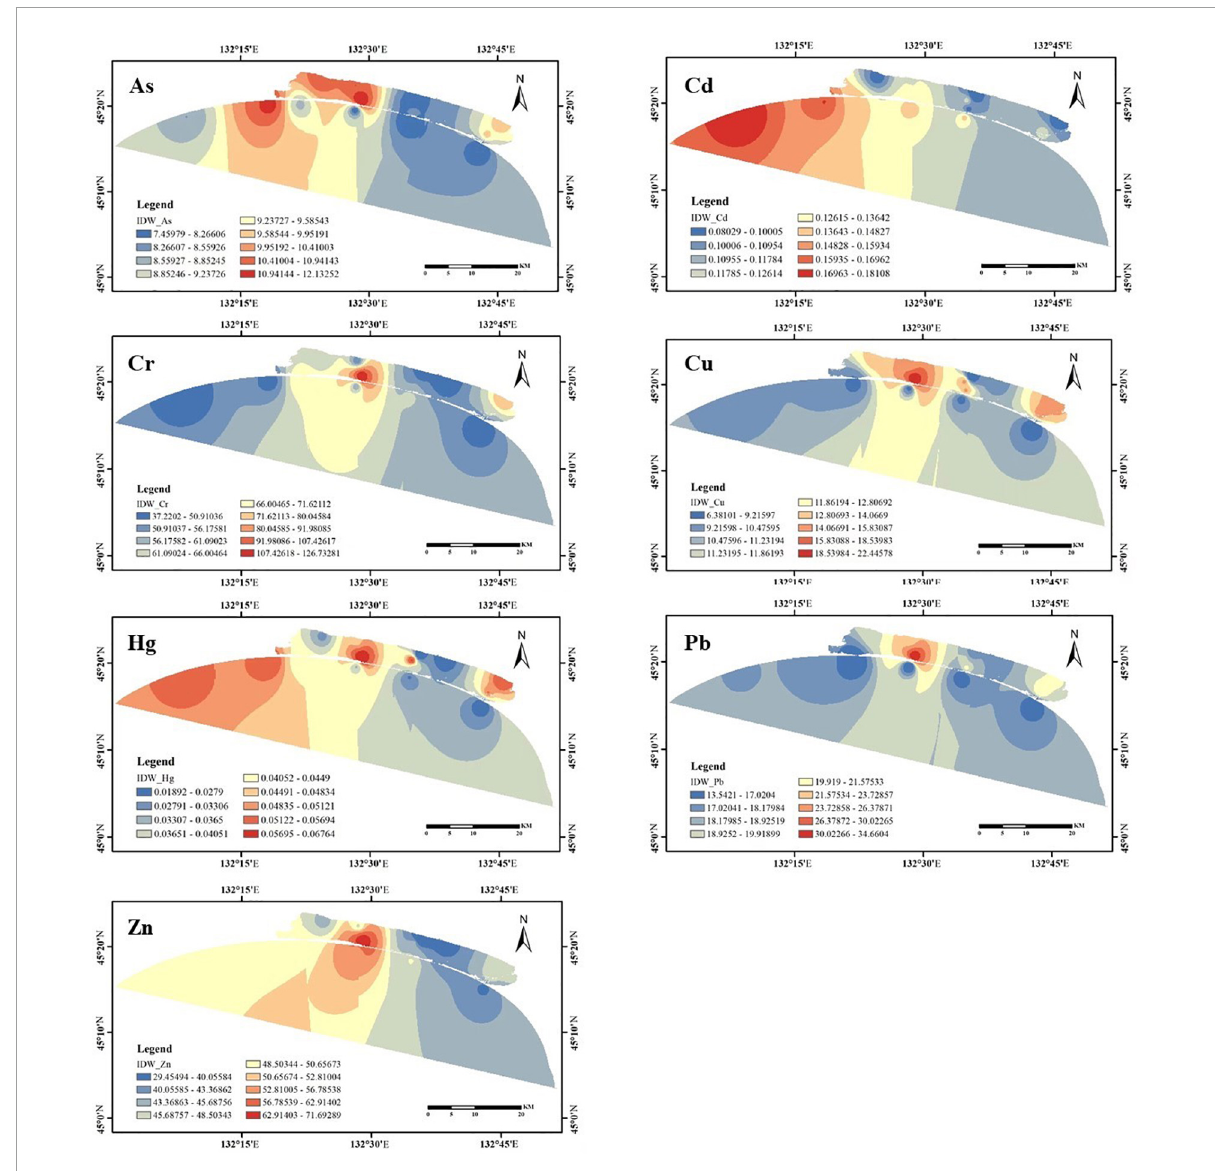
FIGURE2 Spatial distribution of heavy metals in sediments in two lakes using IDW spatial interpolation